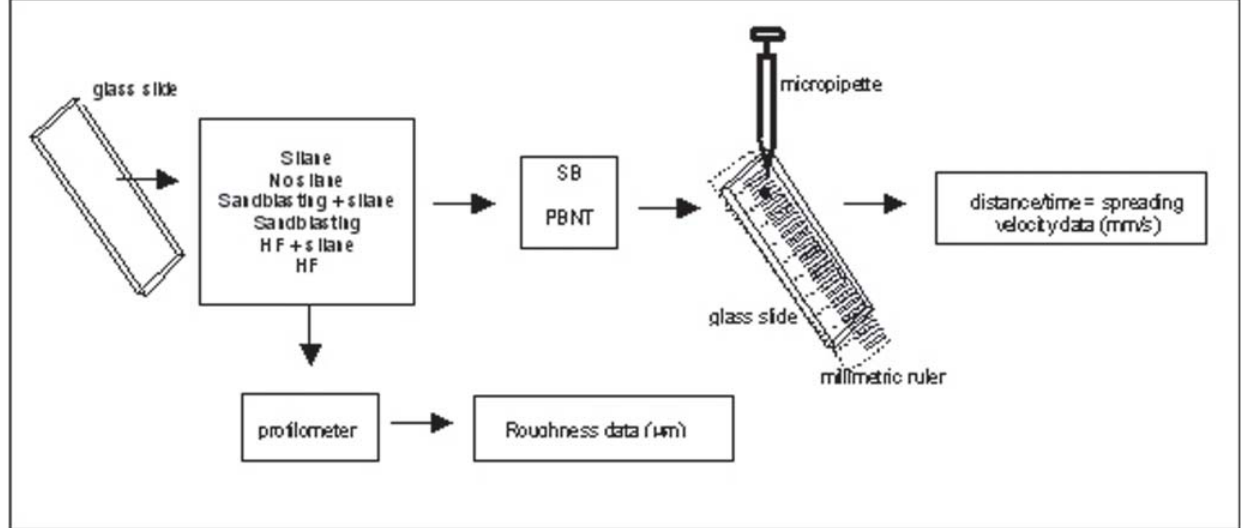
FIGURE 1- Scheme of study groups and experimental